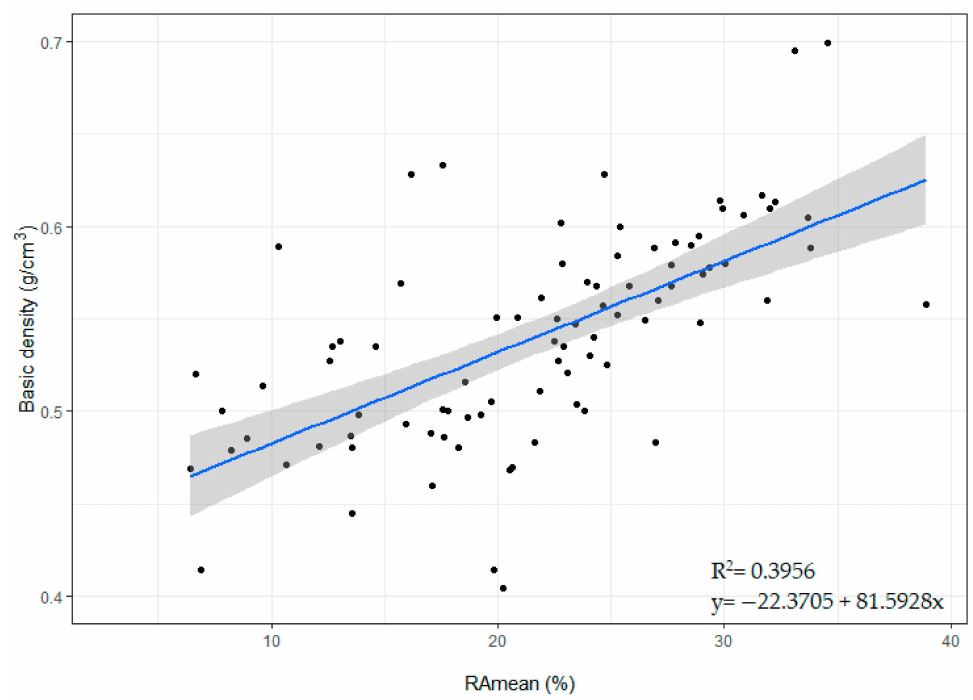
Figure 6. Relationship between mean Resi amplitude (%) and basic density (g/cm 3 ) calculated using linear regression with 50 cm/min drilling speed and 1500 RPM.